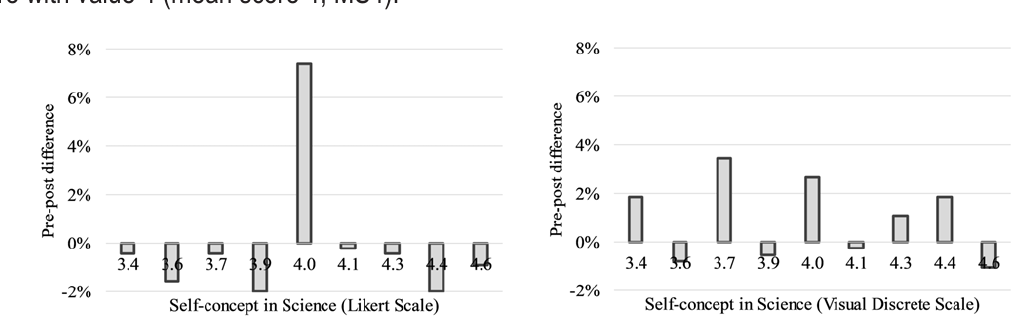
Figure 4. Pre-post changes around M=4.0 in self-concept in science. Percentage changes in the mean scores of self-concept in science from before (pre) to after (post) a visit to the Tūhura science centre around mean score 4: a) Likert-type scale (left), N=446, b) visual discrete scale (right),